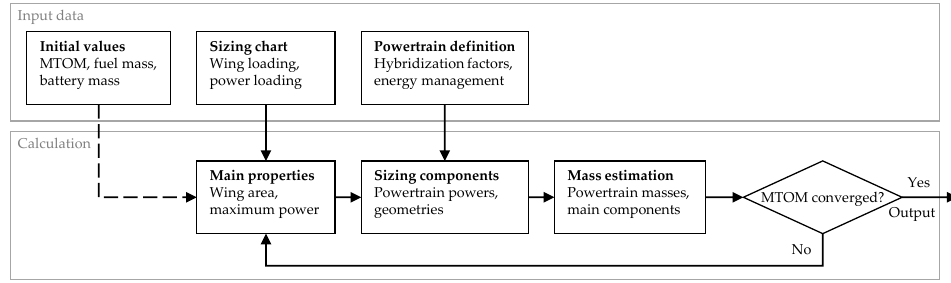
Figure 5. Schematic flowchart of the inner sizing